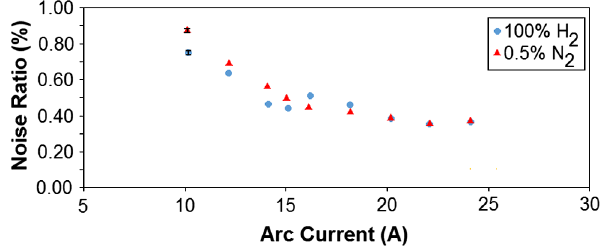
FIG. 17. Noise ratio as a function of arc current with and without N 2 in the gas mixture.